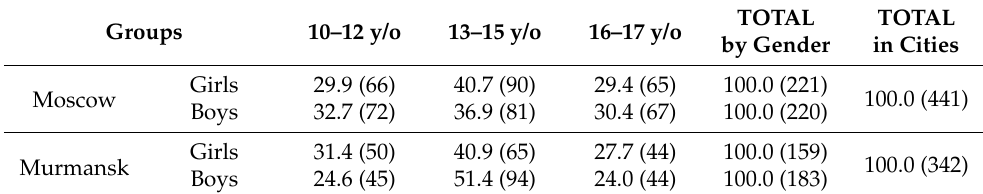
Table 1. General characteristics of the sample, % ( n